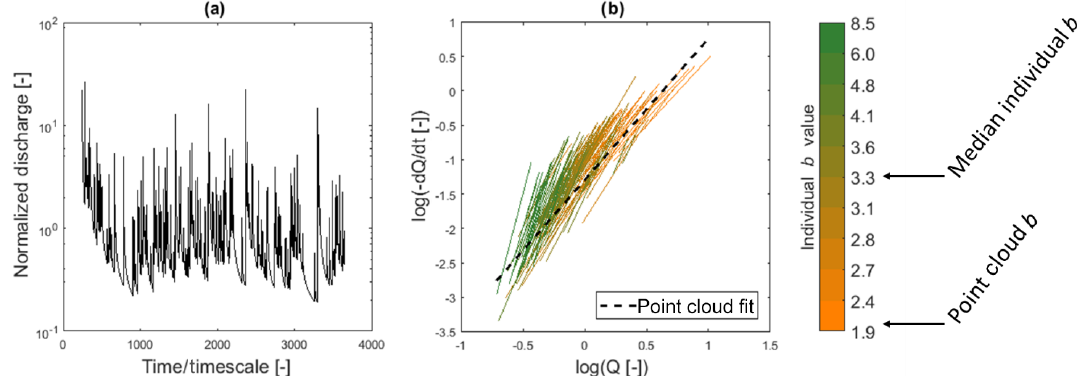
Figure 6. (a) Hydrograph with a log-normal distribution in recharge event inter-arrival times and magnitudes and (b) recession analysis plot showing a large range of b values (with the median of b = 3 . 3), compared to the point cloud fit (black dotted line – BA; b = 2 . 0). The color bar is divided into deciles in the distribution of b values compared to the point cloud